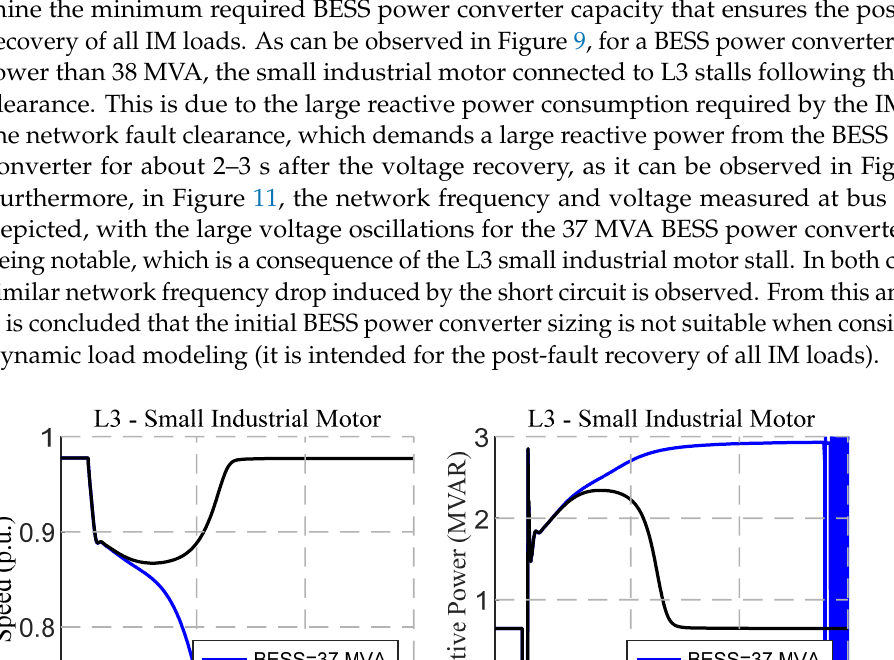
Figure 10. BESS power converter active and reactive power outputs—base case scenario.